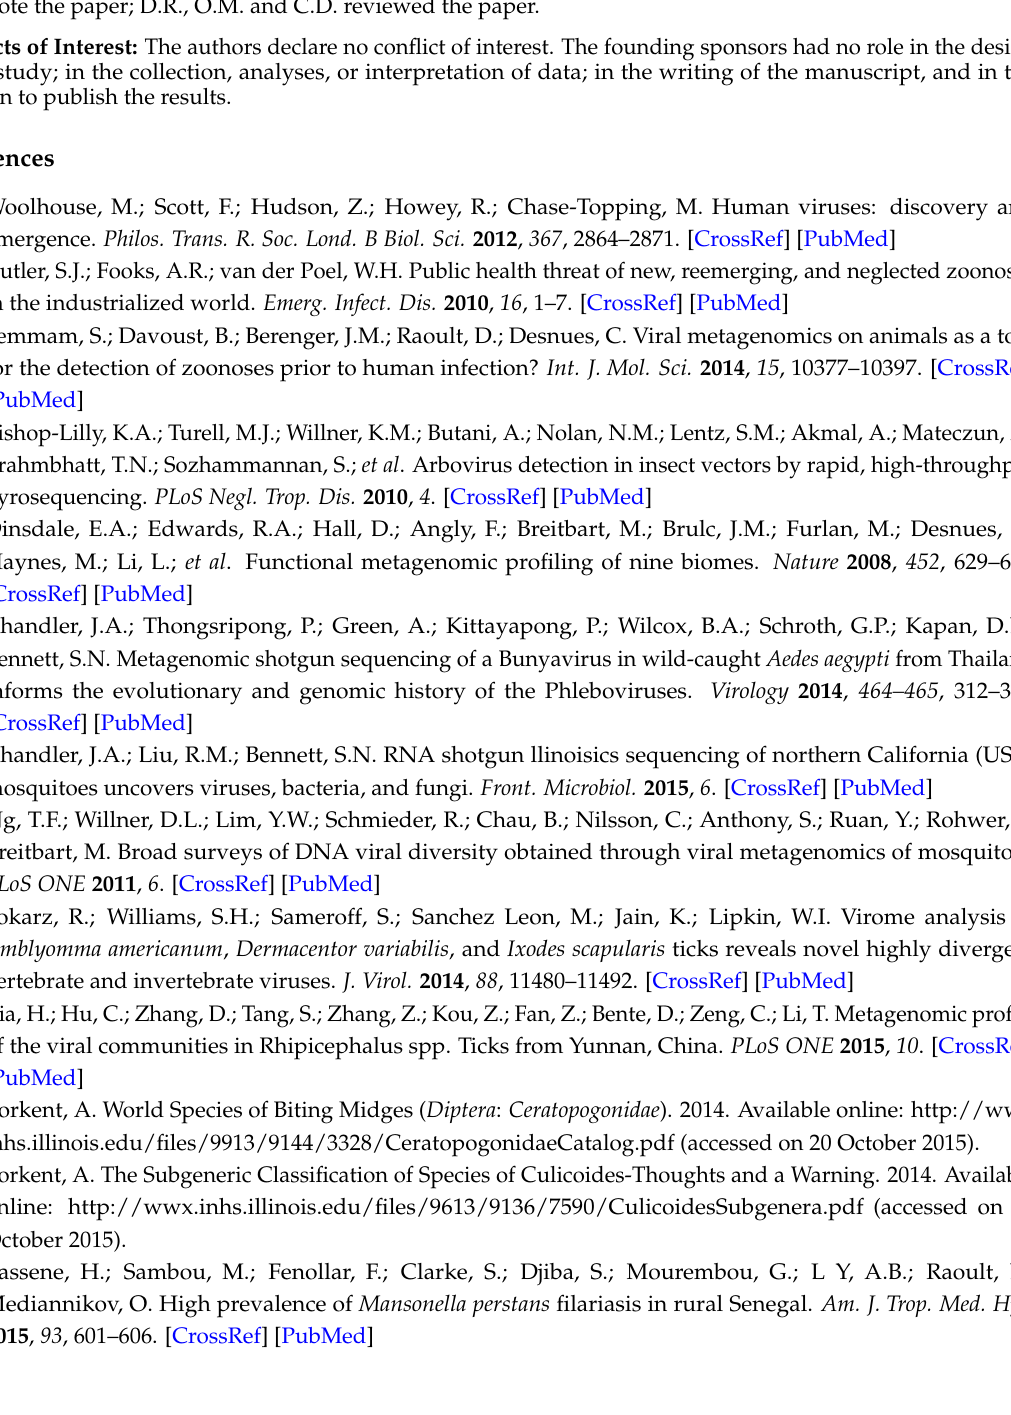
Figure S1: Pipeline for bioinformatic analyses, Figure S2: Phylogenetic analysis of Dielmovirus genus compared to other Rhabdoviridae . Figure S3. Phylogenetic analysis of Dielmovirus genus compared to other Rhabdoviridae and the endogenous viral element A. aegypti . Table S1. Characteristics of metagenomes used for PCA